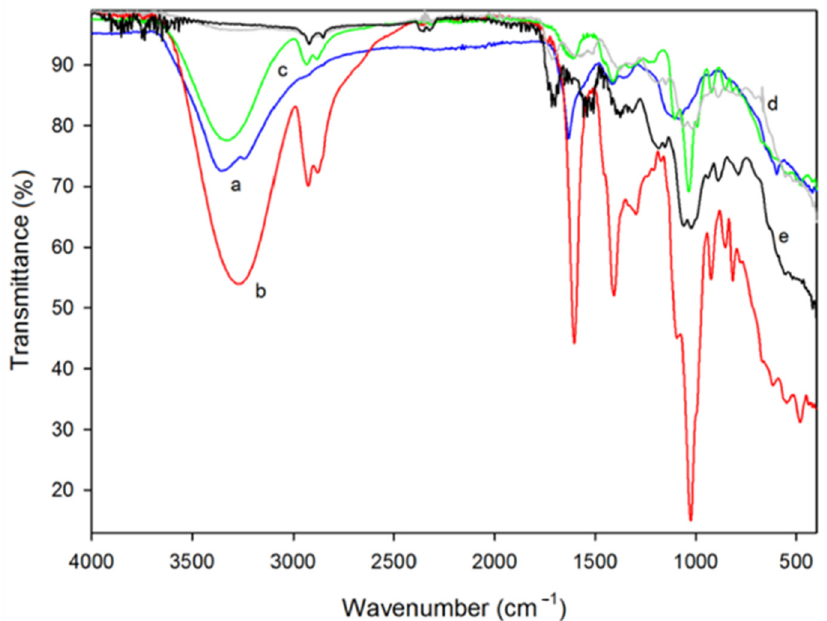
Figure 5. Fourier transform infrared spectroscopy attenuated total reflection (FTIR-ATR) spectrum of the (a) C. tomentosum seaweed extract (blue) and the different tested films: (b) 1% alginate (red), (c) 1% alginate with 0.5% of C. tomentosum seaweed extract (green), (d) 1% chitosan (grey), and (e) 1% chitosan with 0.5% of C. tomentosum seaweed extract (black) [78].